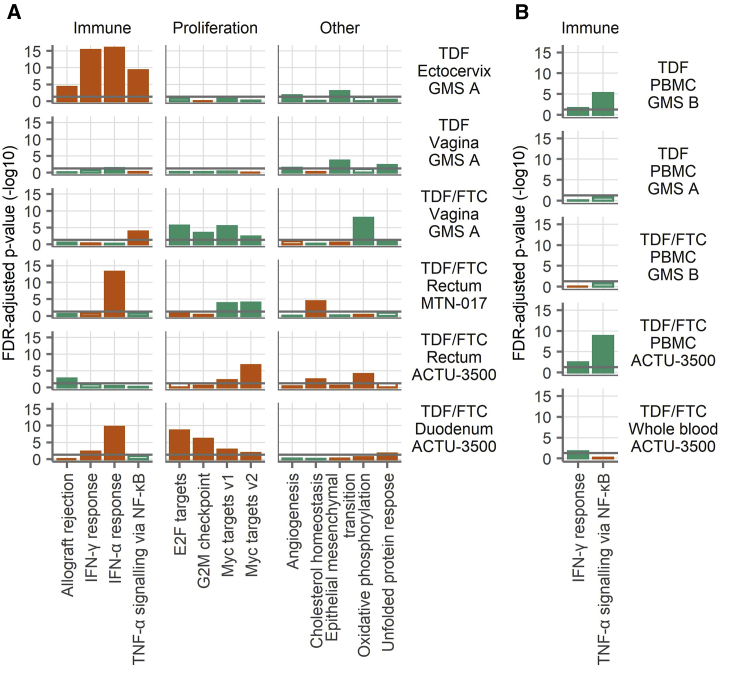
Hallmark Gene Sets(A and B) Gene set testing was performed on the Hallmark gene sets in the mucosa (A) and the blood (B). To reduce the number of gene sets displayed and focus on those gene sets that were affected in multiple studies, we show only those gene sets that had an FDR-adjusted p < 0.05 in at least two of the mucosa (A) or blood (B) study arms. The bars indicate the result of a gene set test for the gene set shown on the x axis tested against the study shown at right. The filled bars indicate an FDR-adjusted p < 0.05 and open bars the opposite, with the bar length proportional to the −log10 of the FDR-adjusted p value. The colors indicate the direction of change, with orange indicating more expression during product use and green indicating less expression. The horizontal gray lines show an FDR-adjusted p = 0.05. The gene sets are grouped into categories as labeled at top. The sample sizes are shown in Table 1. Each sample was run in singlicate by microarray.